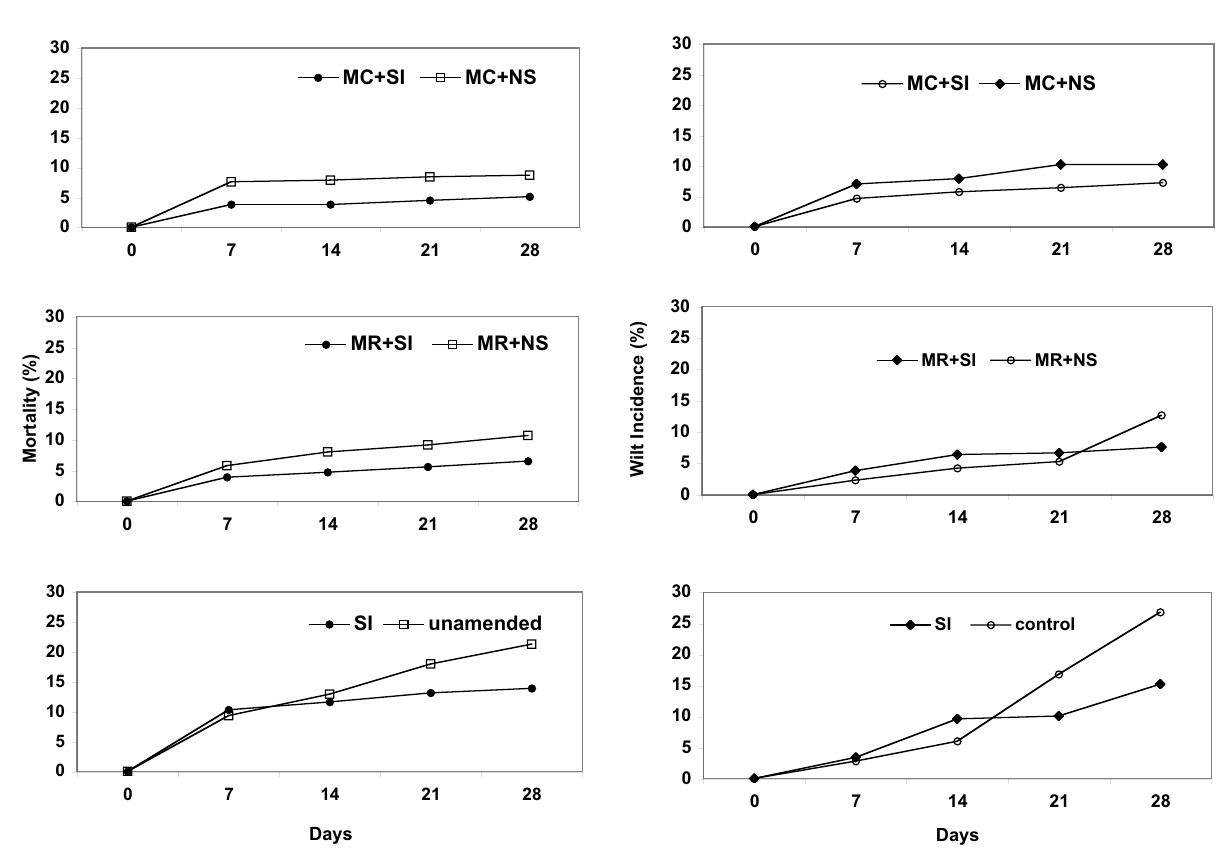
Fig. 2. Wilt incidence of cumin in soils amended with mustard oil-cake (MC), mustard residue (MR), and with summer irrigation (SI) or without summer irrigation (NS, normal sowing). LSD ( P =0.05): treatment 5.2; in- terval 2.9; treatment (cid:1) interval